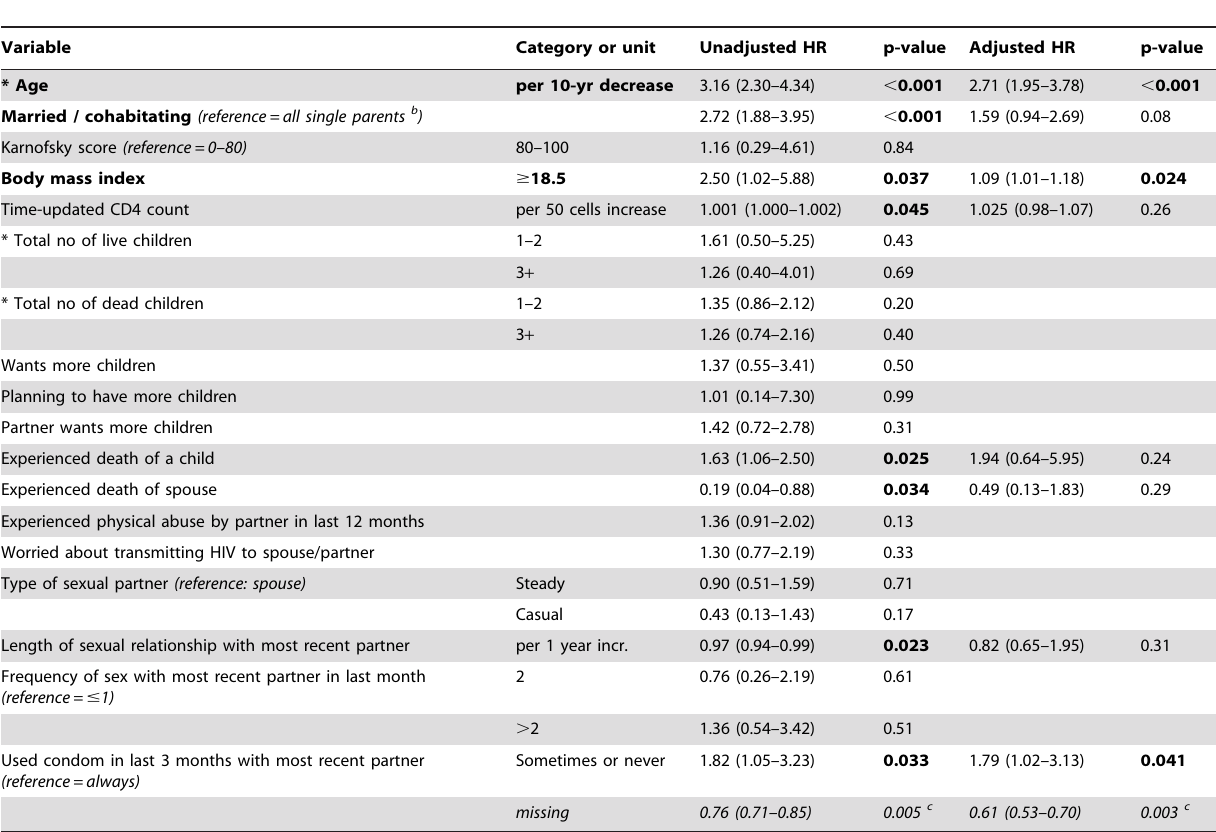
Table 3. Cox proportional hazard analysis of baseline and time-dependent factors associated with pregnancy after ART initiation (N= 117 a